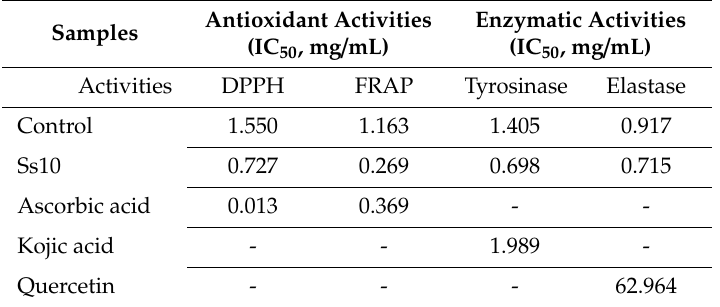
Table 3. Antioxidant and enzymatic activities of Scenedesmus sp. extracts. Control: Scenedesmus sp. cultured in MDM medium without salt. Ss10: Scenedesmus sp. stressed by 10 g / L of NaCl. Ascorbic acid, kojic acid, and quercetin standards are used as positive controls for antioxidant, tyrosinase, and elastase activities,